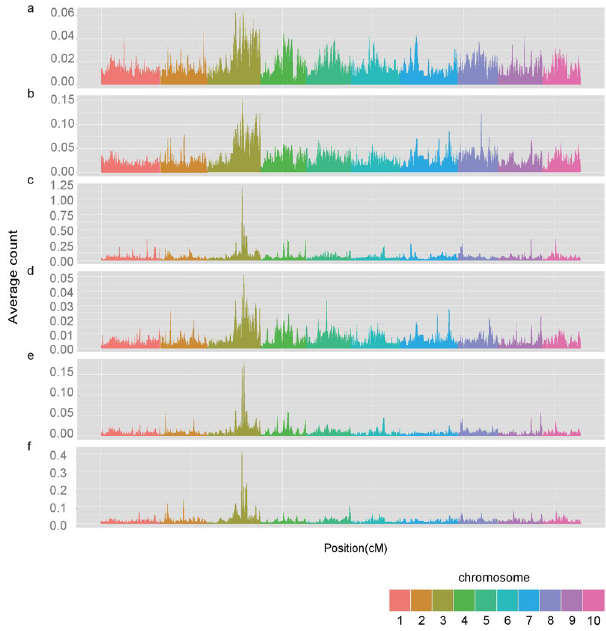
Figure 6. Hotspots of IBD sharing within populations and across populations. The occurrence of IBD is averaged by sample number and is indicated on the y axis. IBD occurrence ( a ) within the TS population; ( b ) within the NSS population; ( c ) within the SS population; ( d ) between the TS and NSS populations; ( e ) between the TS and SS populations; ( f ) between the NSS and SS